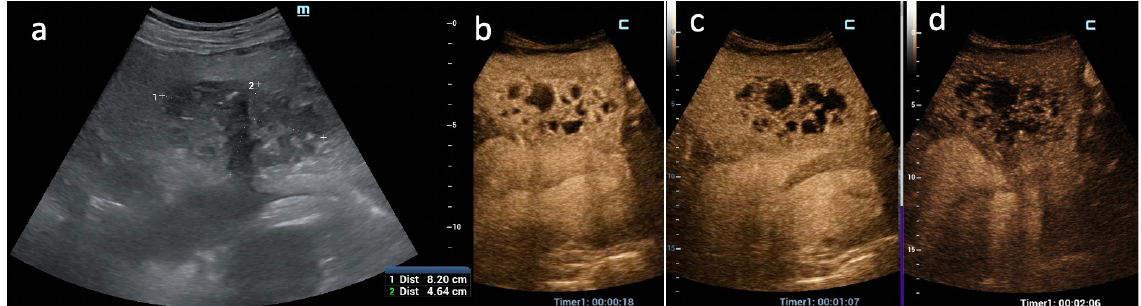
Figure 3. CEUS PLA type II. (a) An 8-cm solid mass of the left hepatic lobe is displayed at US B-mode; (b) in the arterial phase after US contrast agent injection a typical “honeycomb” pattern is displayed due to alternating small, liquified (non-enhanced) areas and inflamed (hyperenhanced) parenchyma; (c–d) in the portal and late venous phases the solid